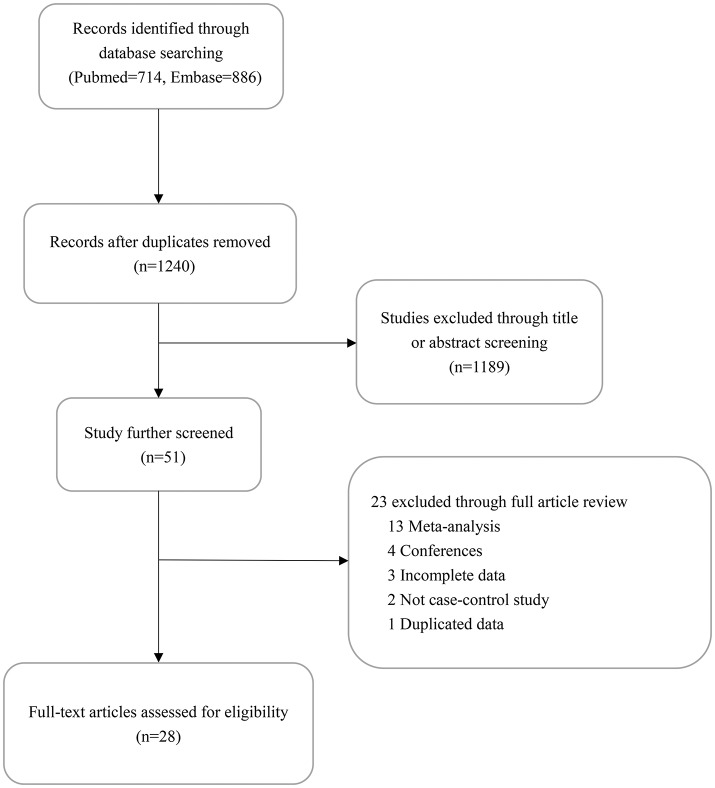
Flow Diagram describing literature selection.